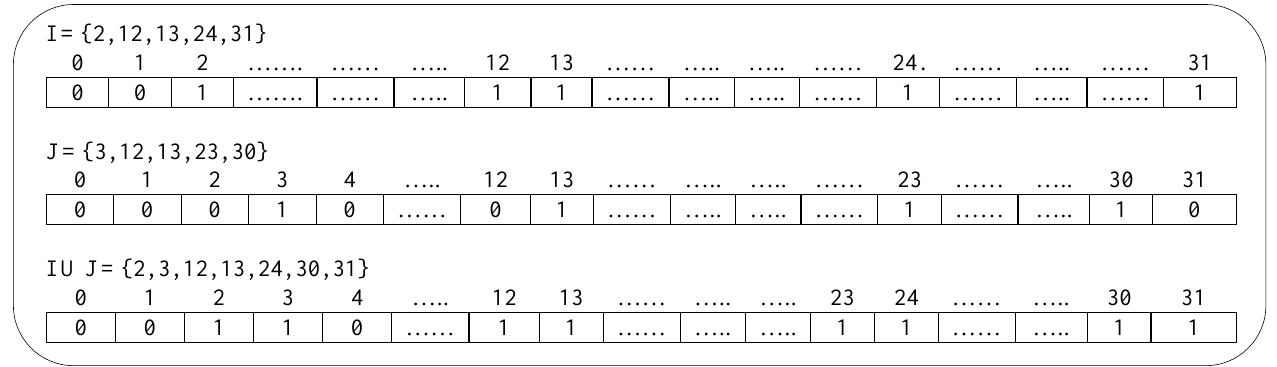
Figure 2. Union operation of the itemsets I = {2, 12, 13, 24, 31} and J = {3, 12, 13, 23, 30}.